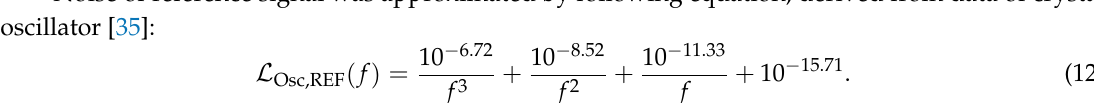
Table 2. Comparison of calculated parameters of frequency synthesisers to other works.